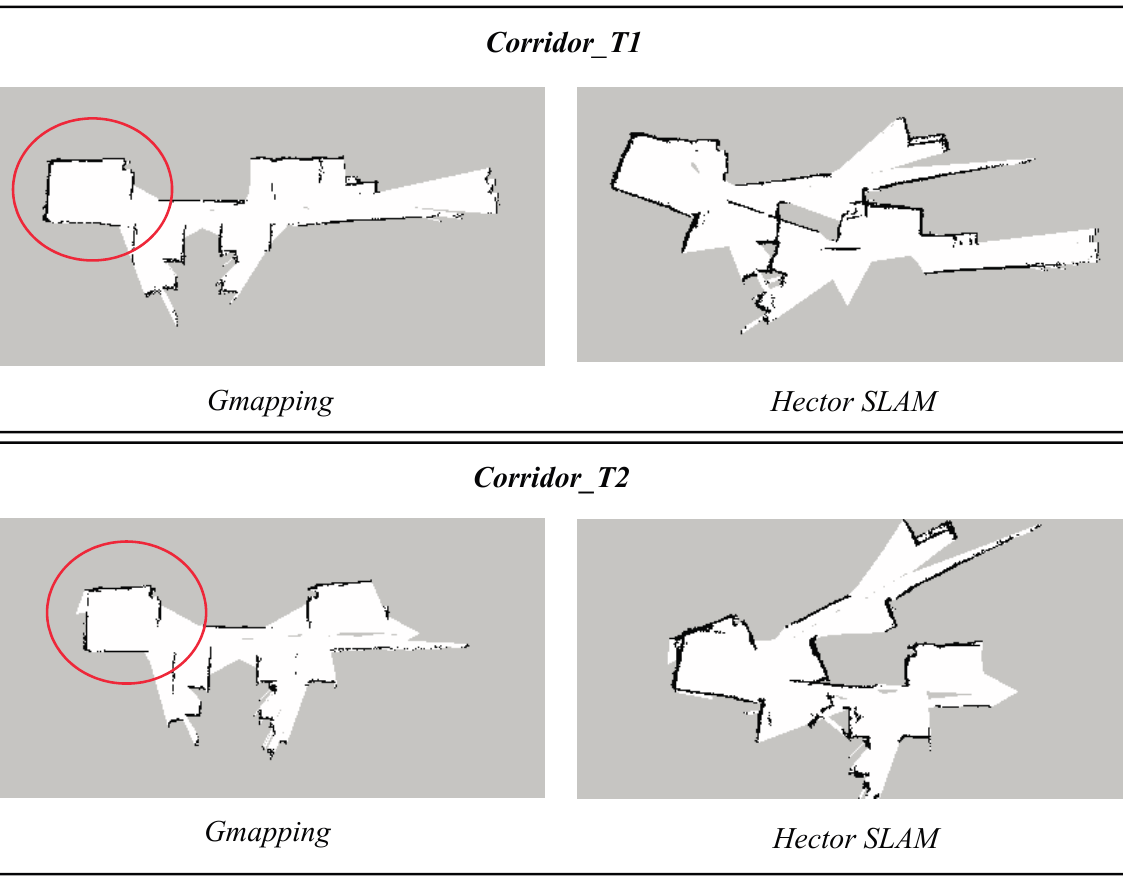
Figure 8. Comparison of maps obtained using Gmapping and Hector SLAM using default parameters.